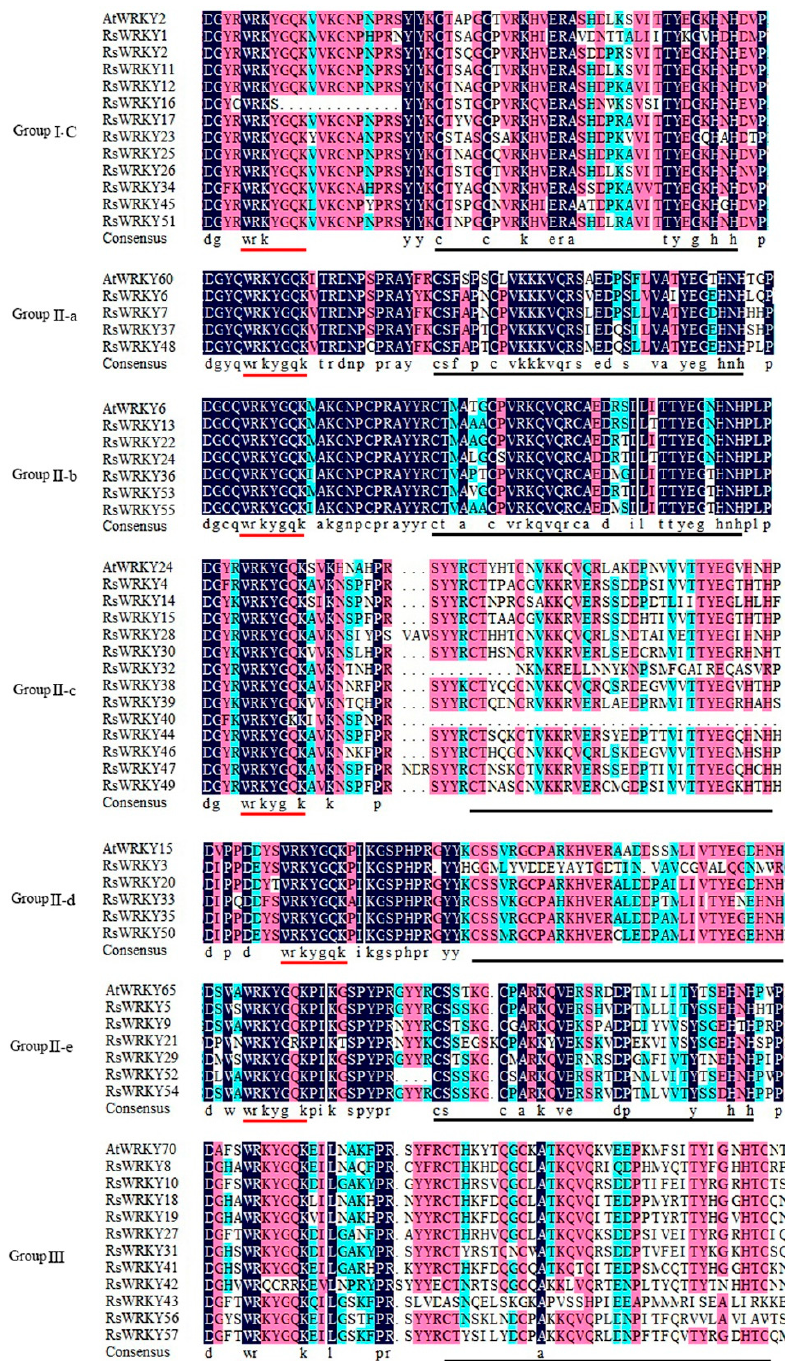
Figure 3. Multiple alignments of RsWRKY proteins and selected AtWRKY amino acid sequences. “-N” and “-C” indicate the N-terminal and C-terminal WRKY domains of Group I WRKY members, respectively. The red solid line represents the highly conserved WRKYGQK heptapeptide, and the black solid line represents the zinc finger